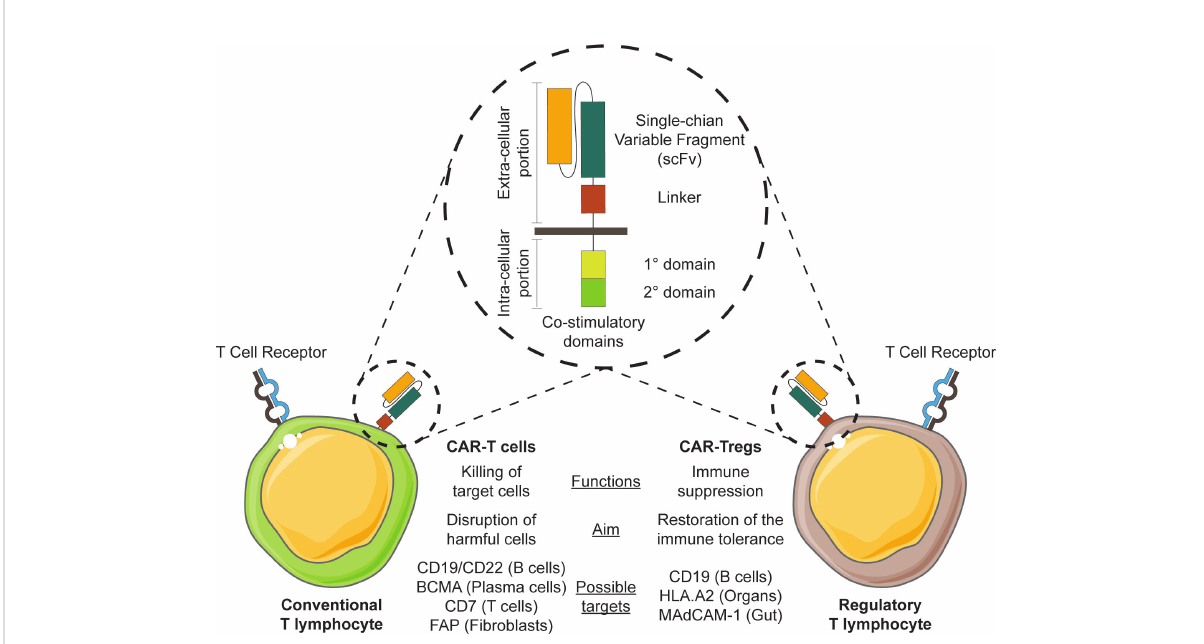
FIGURE 2 Exploiting CAR-T cell therapy for chronic GVHD. The engineering of CAR constructs (illustrated in the circle) in conventional T cells or T regulatory cells may be exploited in therapy for chronic